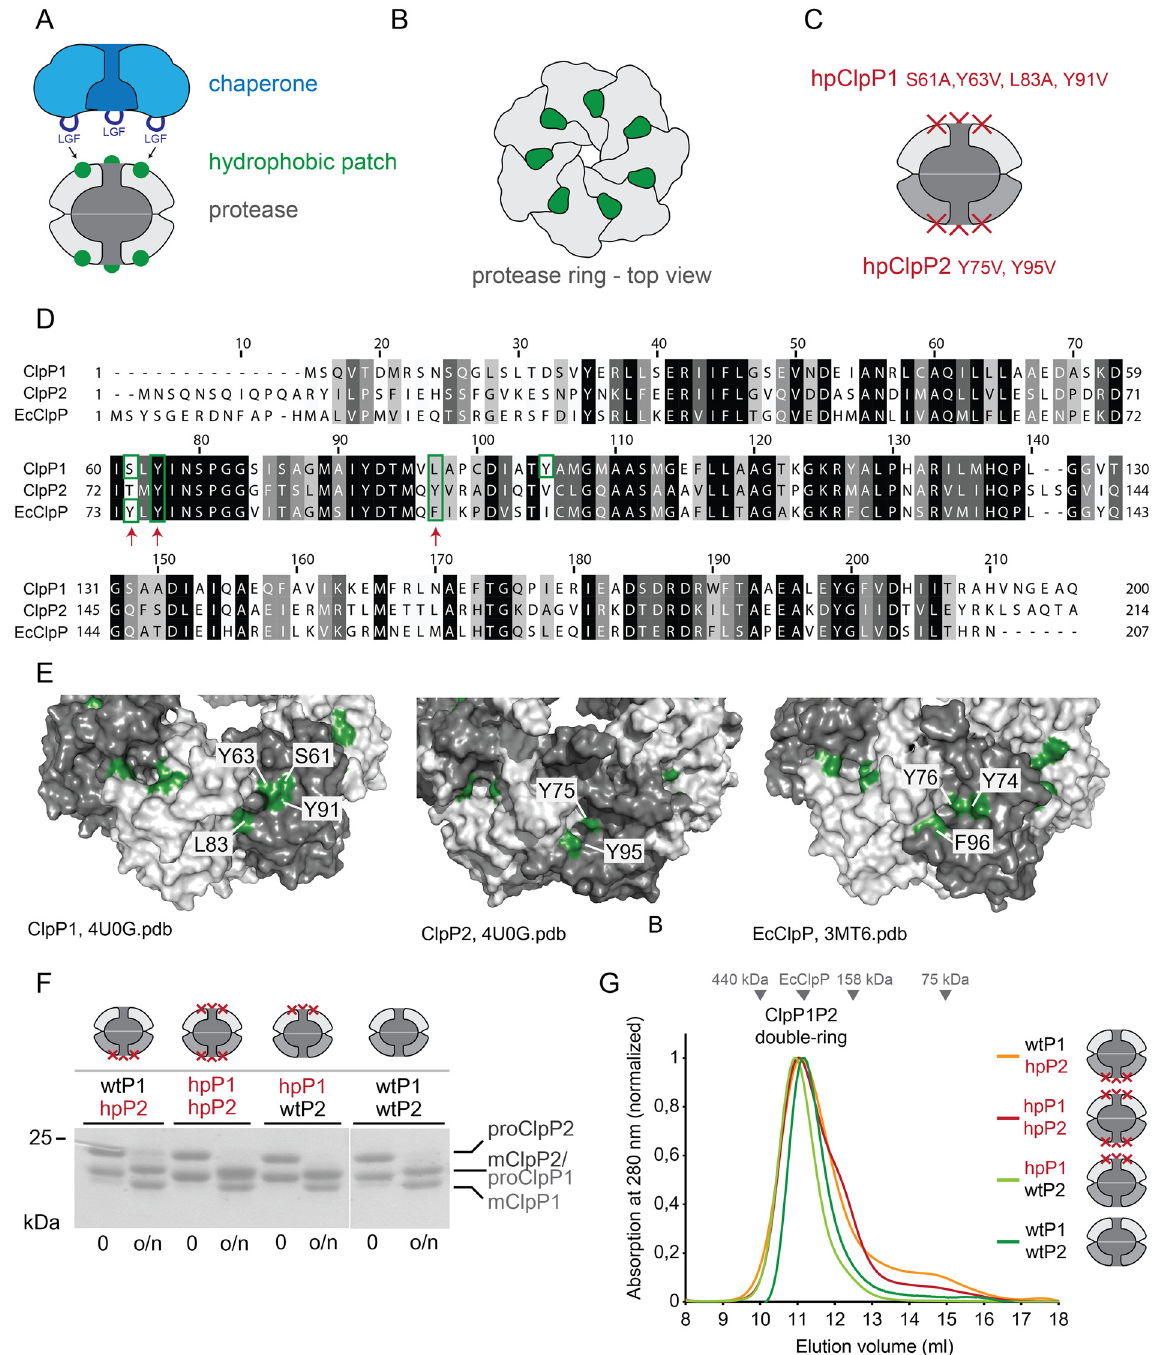
Fig 3. Generation of hydrophobic patch variants of ClpP1 and ClpP2. A. Cartoon representation of the LGF-loops (dark blue) of the chaperone binding to hydrophobic surface patches (green) on the protease core (grey). B. Top view of a heptameric protease ring. The hydrophobic patches (green) are formed by residues of two adjacent protease subunits (grey). C. Mutations introduced in ClpP1 and ClpP2 to create the hydrophobic patch variants hpClpP1 (ClpP1 S61A, Y63V, L83A, Y91V ) and hpClpP2 (ClpP2 Y75V, Y95V ). D. Alignment of Mtb ClpP1 and ClpP2 with EcClpP. Conservation is colored from white (not conserved) to black (identical). The identity between ClpP1/ClpP2 is 39.5%, between EcClpP/ClpP1 46% and EcClpP/ClpP2 44.4%. Red arrows highlight the residue positions of the EcClpP hydrophobic patch residues. Residues depicted in green in panel E are marked with a green box. E. Surface representation of ClpP1, ClpP2 (4U0G.pdb) and EcClpP (3MT6.pdb) ring faces. Individual subunits are colored alternatingly in light and dark grey. Hydrophobic patch residues are colored in green and labelled accordingly. For ClpP1 and ClpP2 the hydrophobic patch residues used for mutation are shown, for EcClpP reference residues are shown as described in the literature [14]. F. Creation of a set of mature mixed wild-type ClpP1 and ClpP2 (wtP1,